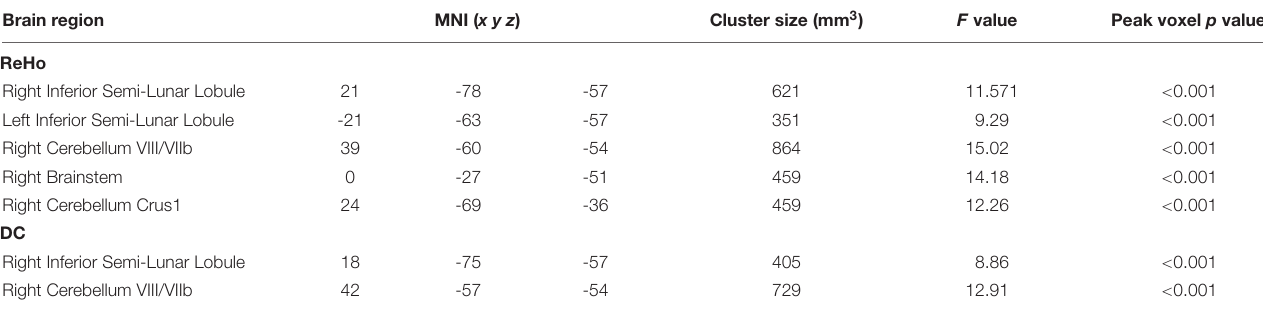
TABLE 2 | Alterations in activity (post- minus pre-rTMS) in different brain regions for the High, Low, and Sham stimulation conditions from one-way ANOVAs. Brain